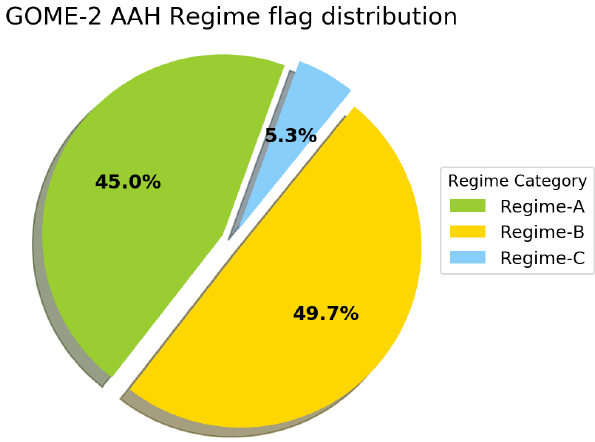
Figure 6. Distribution of AAH product reliability (regime flag) re- lated to degree of cloud cover (effective cloud fraction) for the se- lected collocated observations as per Sect. 3.1.2 (A: high reliability, B: medium reliability, C: low reliability).